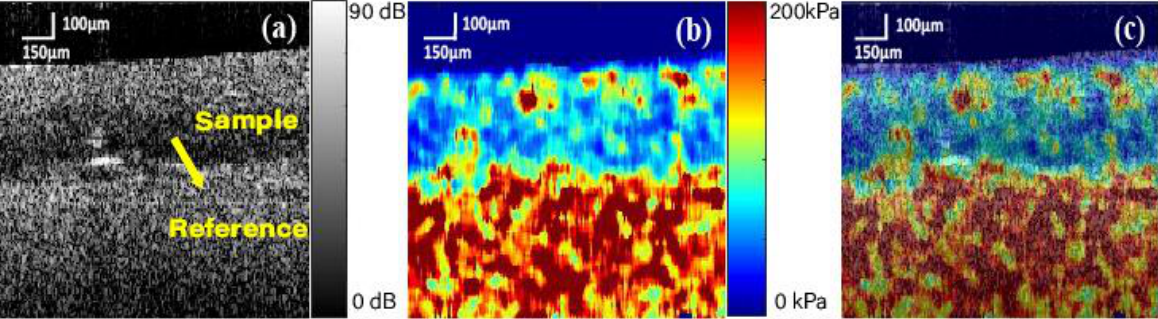
Figure 7. ( a ) Structure image of oesophageal tissue sample in dB scale; ( b ) Elasticity image of the corresponding oesophageal tissue sample in kPa scale; ( c ) Overlaid image of structure and elasticity image.